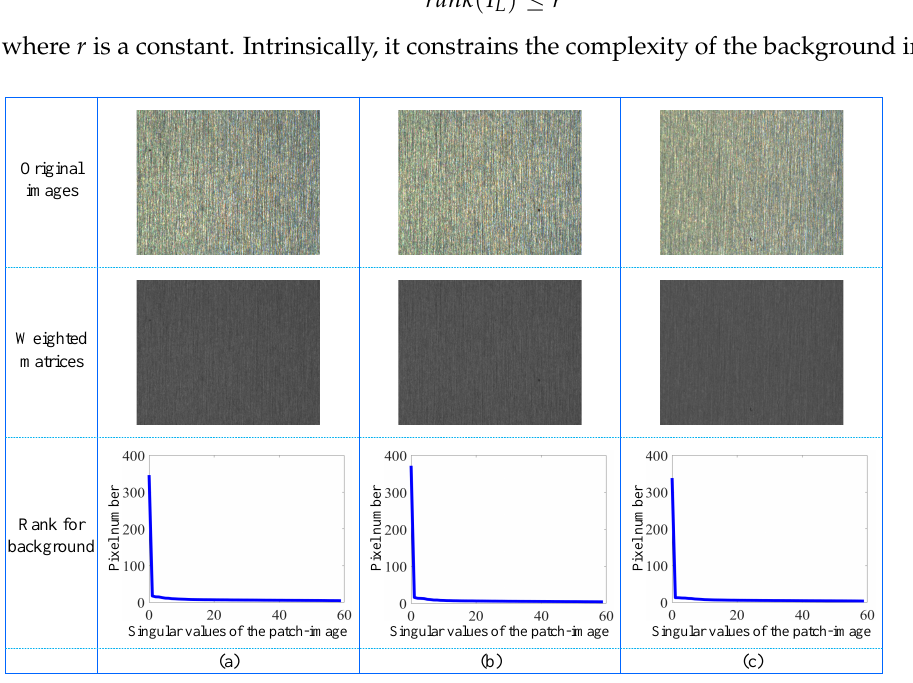
Figure 6. Low-rank matrix analysis. The first column shows three representative examples. In addition, the second and third one are weighted matrices and the singular values of the corresponding background